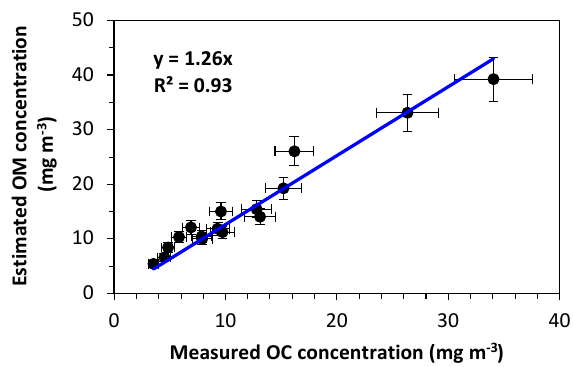
Figure 2. Linear regression of the measured organic carbon (OC) concentration versus the estimated organic matter (OM) concentra- tion in sampled plumes that was calculated as the difference be- tween PM 2 . 5 mass and the sum of EC, water-soluble ions, and metal